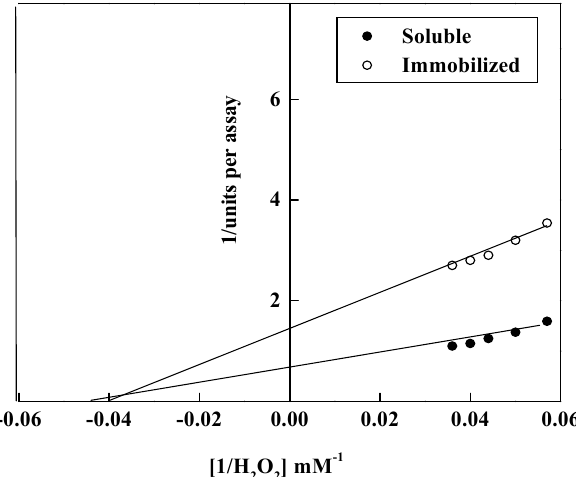
Figure 7. Lineweaver-Burk plot relating soluble catalase and immobilized catalase reaction velocity to H 2 O 2 concentrations.